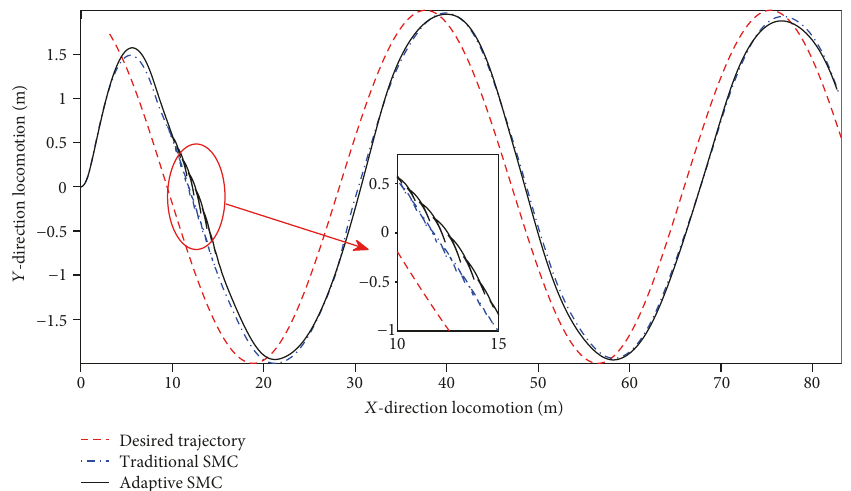
Figure 8: The comparisons of position changes with SMCs.